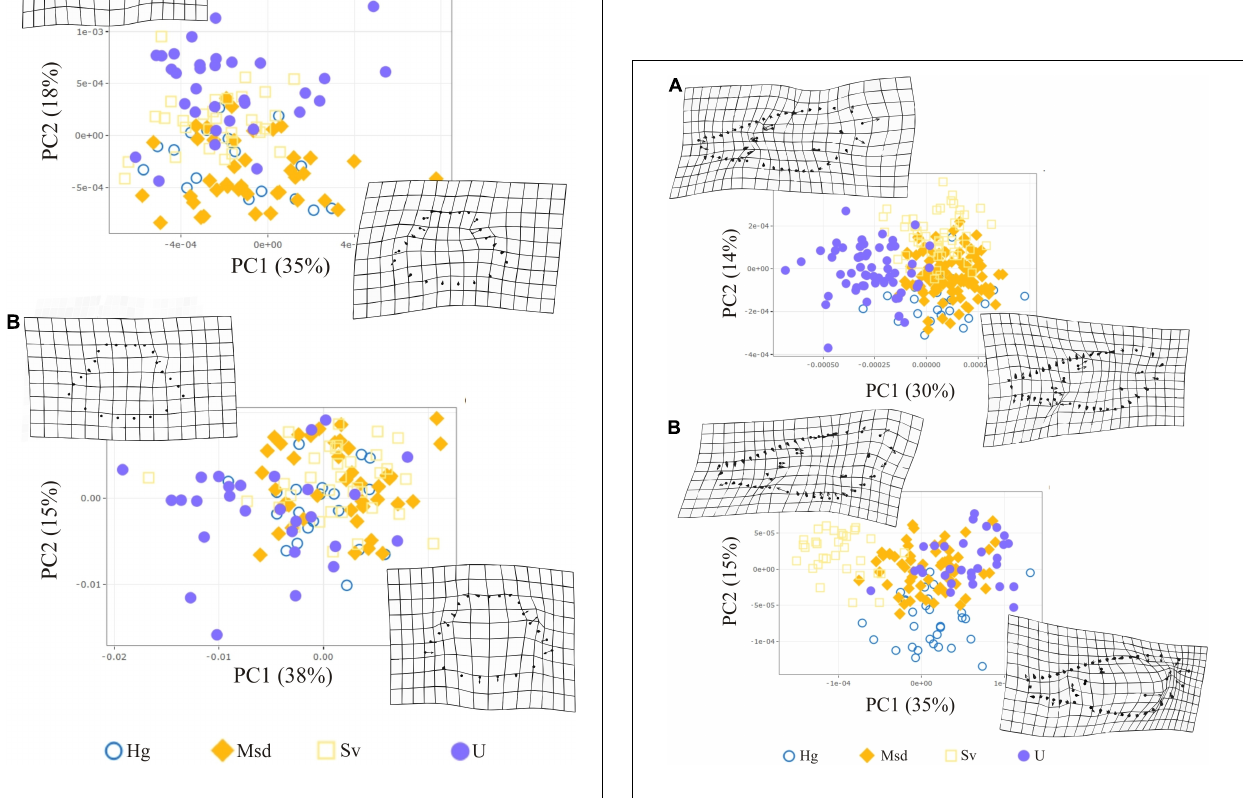
FIGURE 5 | PCA of wing shape variation for T. dimidiata females (A) and males (B) . Urban (U), Homegarden (Hg), Secondary vegetation (Sv), and Median subdeciduous tropical forest